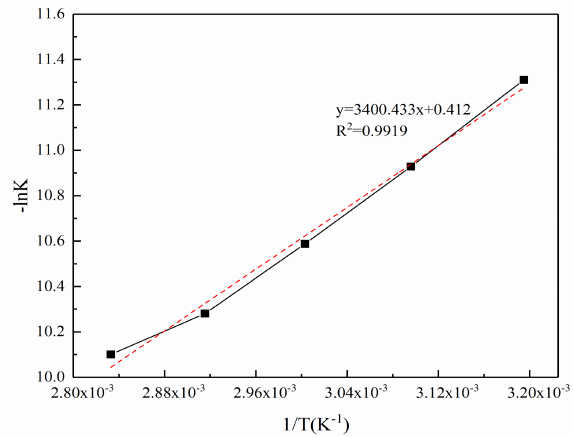
Figure 4. Fitting curves of − lnK and